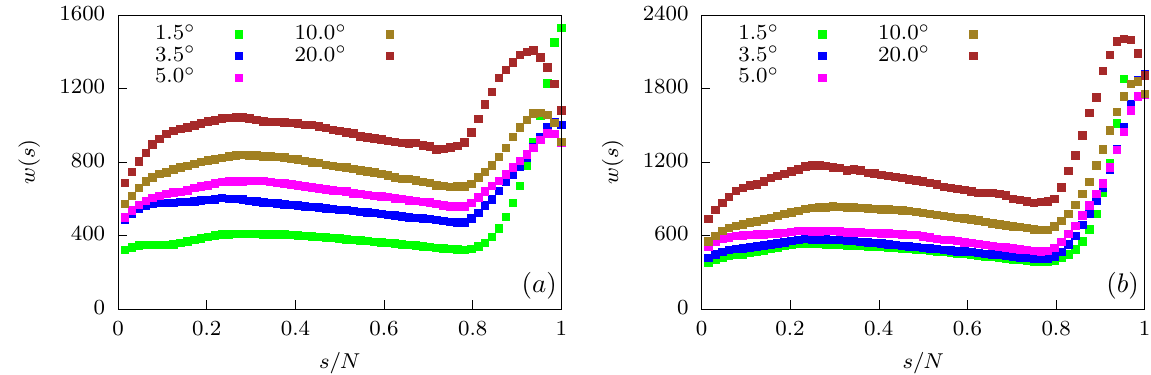
Figure 12. Waiting time distributions for various α at ( a ) κ = 2 , and ( b ) κ = 4 for f 0 = 0.2 . The distributions show distinct differences as the bending rigidity of the polymer is